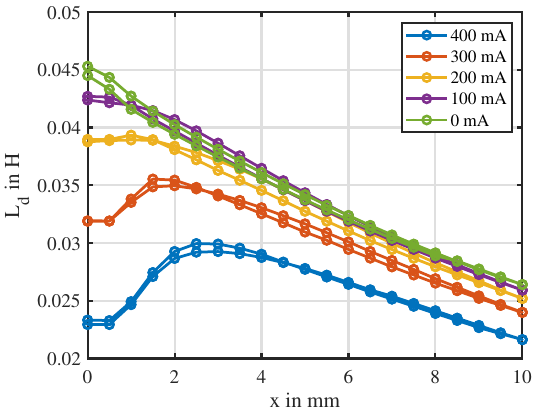
Figure 13. Characteristic of the differential inductance over the position at different fixed currents. Measurement points are indicated by dotted